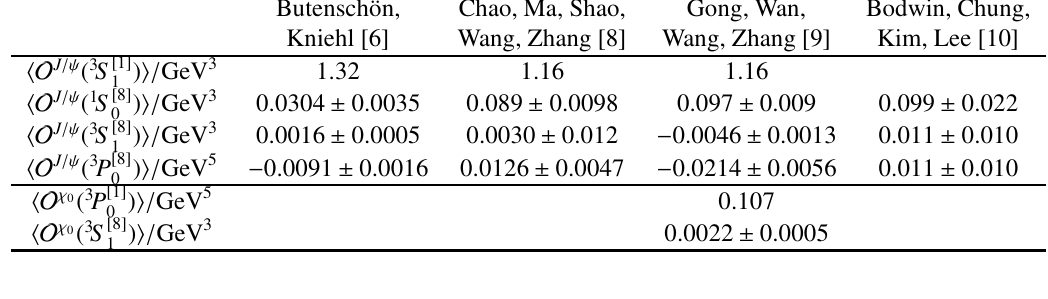
Table 1. Sets of J /ψ and χ c 0 LDMEs determined in Refs. [6,